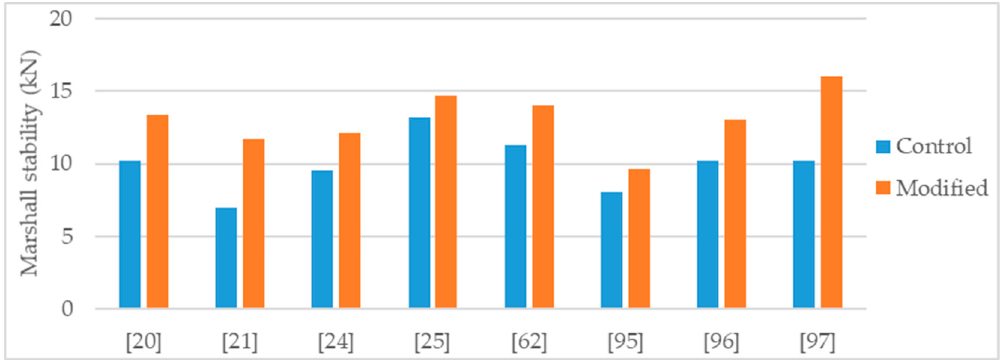
Figure 2. Marshall stability of control and nanosilica modified asphalt mixtures.